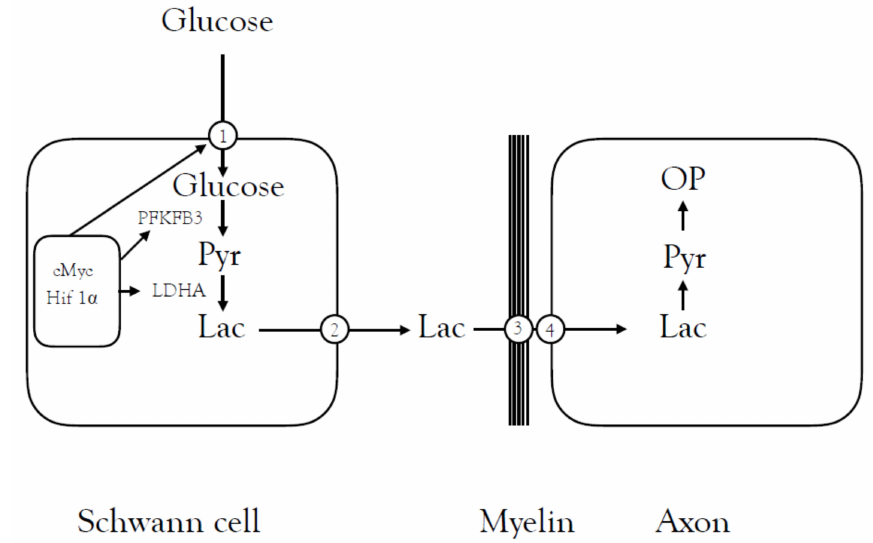
Figure 4. The role of lactate shuttling in axon regeneration in peripheral axons. In the aftermath of injury to peripheral axons, there is an upregulation of the transcription factor targets cMyc and Hif 1 α , which leads to increased expression of the Glut1 transporter (1) facilitating glucose uptake. The glycolytic activator PFKFB3 is upregulated as is the enzyme LDHA, which converts pyruvate to lactate. The MCTs that facilitate lactate e ffl ux from the astrocyte (2) and uptake into axons are present on the myelin (3) and axon (4)